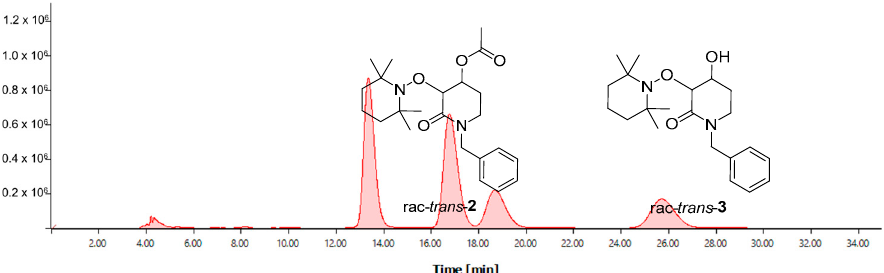
Figure 2. Chiral-HPLC chromatogram of the 2:1 mixture of both rac-trans - 2 and rac-trans - 3. Percolated crude reactions, where rac - trans - 3 de-acylated product predominates, were analyzed using the Chiral-Column HPLC technique. Although with low conversion, an excellent enantiomeric excess (99% ee , [ α ] D20 = +45.2, c 1.0, CHCl 3 ) was obtained, which means that the enzymatic resolution of rac-trans - 2 proceeds enantiospecifically (Figure 3), and, moreover, it is a worthwhile method because of the high value (380) obtained for the enantiomeric ratio ( E ).